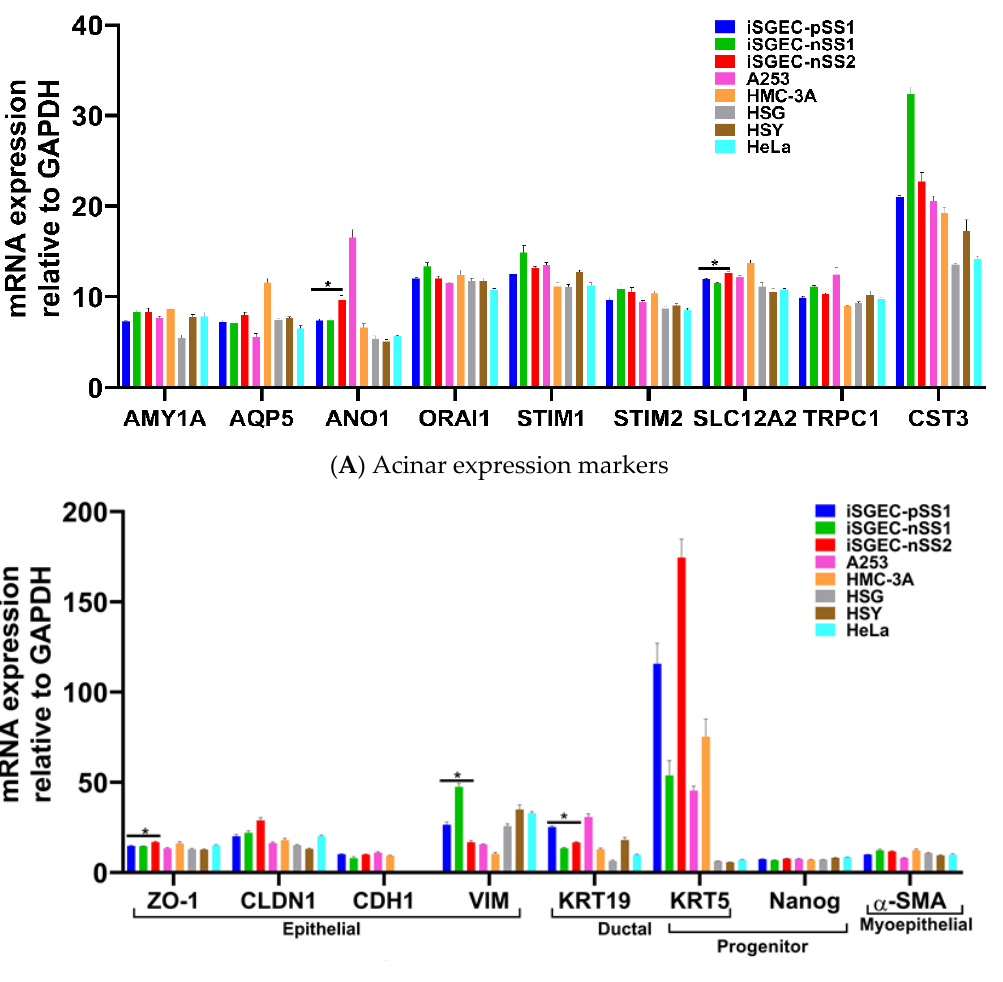
Figure 3. mRNA expression of acinar and characterization markers in monolayer cultured iSGECs, SGCLs, and HeLa cells by qRT-PCR. Legend. ( A ) Pro-acinar markers were highly expressed in all iSGECs. ANO1 and SLC12A2 were expressed highest in iSGEC-nSS2 compared to other iSGECs. ( B ) Characterization markers for epithelial, ductal, progenitor, and myoepithelial expression in all cell lines examined. The epithelial marker ZO-1 is an integral component of tight junctions and was overexpressed, whereas Vimentin (VIM) was under-expressed in iSGEC-nSS2. KRT-19, a ductal cell marker, was differentially expressed in iSGECs. * Indicates significant difference in expression determined by Student’s t -test (alpha = 0.05) and corrected using the Holm–Šidák method. Error bars represent mean +/− SEM.